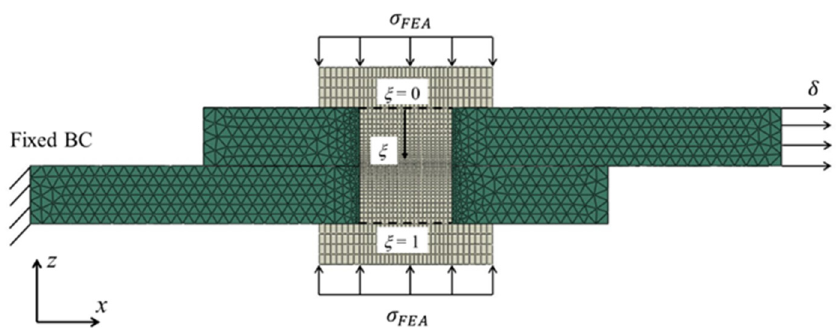
Figure 4. Boundary conditions and mesh on the rivet joint.